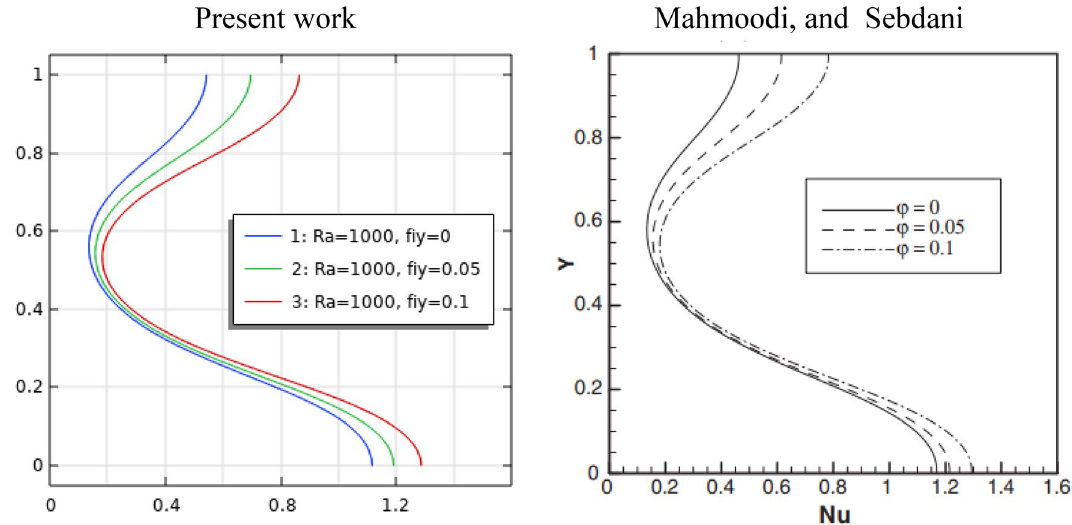
Figure 5. Comparison of the local Nusselt number with Mahmoodi and Sebdani’s 59 study at aspect ratio equal 0.6.